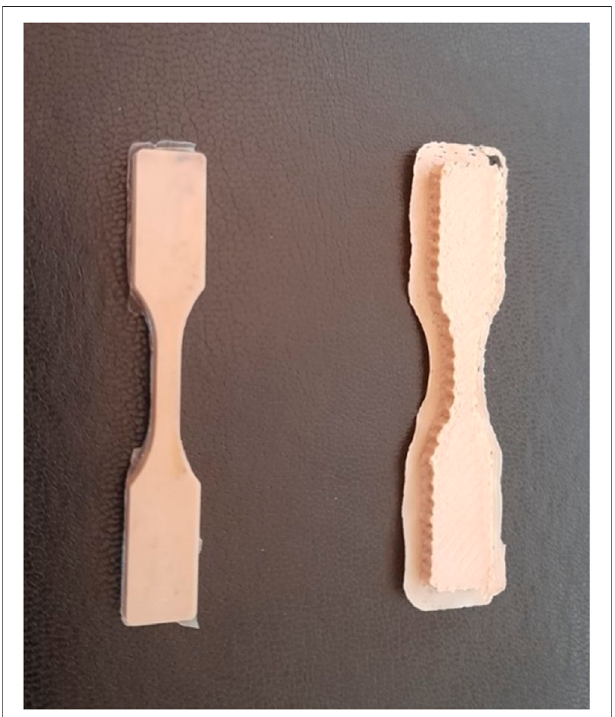
FIGURE 1 | Images of injection moulded and 3D-printed PEEK, from left to right.